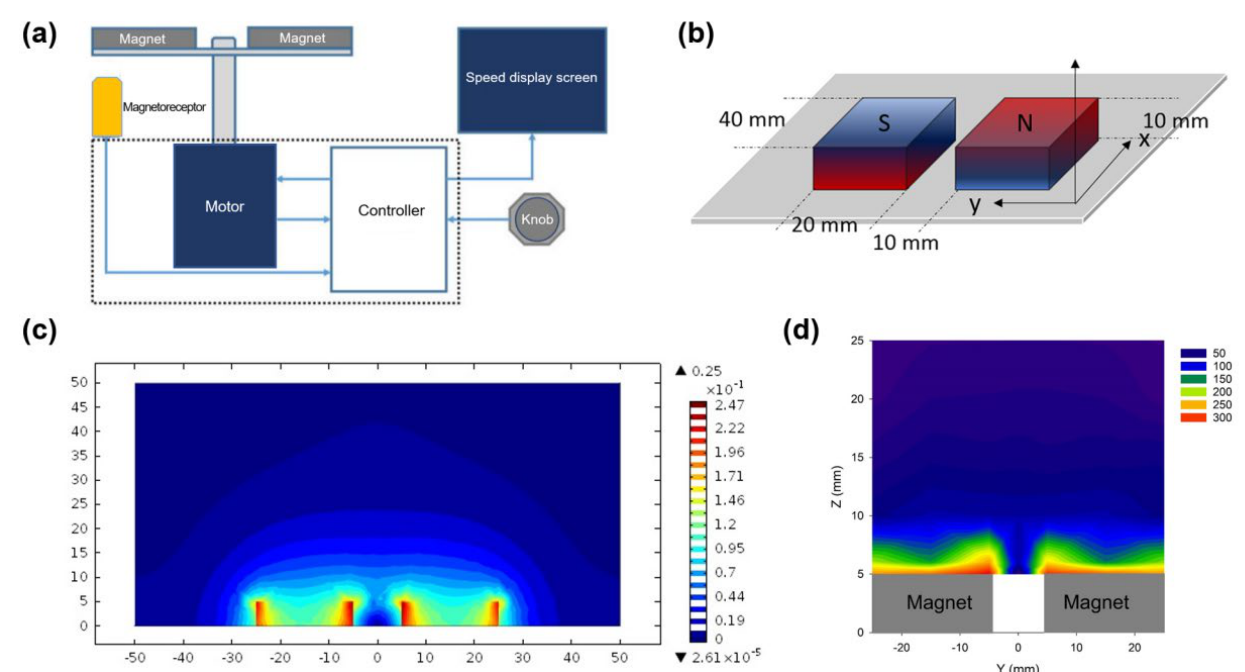
Figure 3. Rotational magnetic field for actuation of the nanochains. ( a ) Block diagram of the rotational magnetic field. ( b ) Model of the pair of magnets for simulation. ( c ) Contour map in the yz plane of the simulated magnetic field (Unit: Tesla). ( d ) Contour map in the yz plane of the magnetic field obtained by experimental measurement (35 positions totally at −25, −15, −5, 0, 5, 15, 25 mm on the y axis and 5, 6, 10, 15, 20 mm on the z axis, respectively).